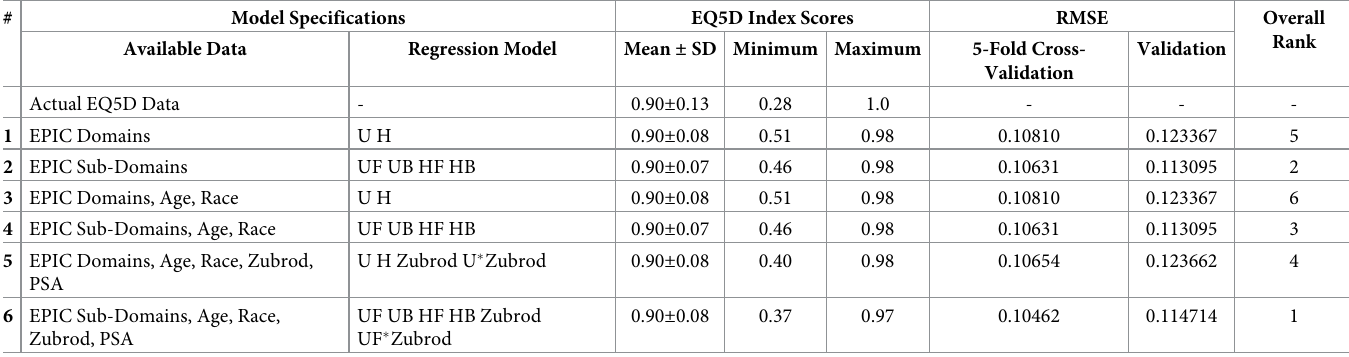
Table 4. Performance of reduced models in internal (5-fold cross-validation) and validation